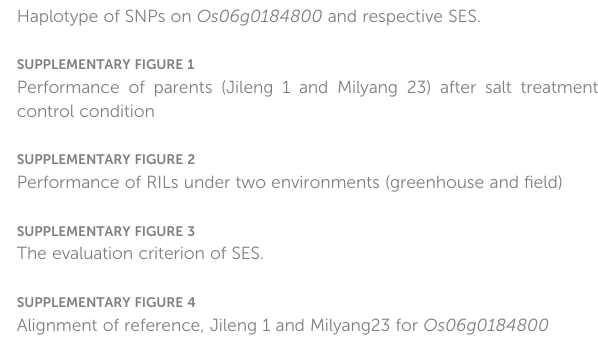
SUPPLEMENTARY TABLE 10 Haplotype of SNPs on Os06g0184800 and respective SES. SUPPLEMENTARY FIGURE 1 Performance of parents (Jileng 1 and Milyang 23) after salt treatment and control condition SUPPLEMENTARY FIGURE 2 Performance of RILs under two environments (greenhouse and fi eld) SUPPLEMENTARY FIGURE 3 The evaluation criterion of